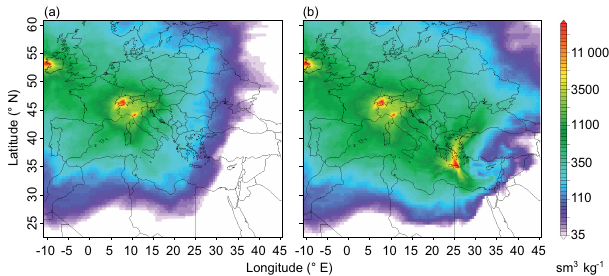
Figure 1. Average FLEXPART-derived source sensitivities for the inversions period and domain for (a) the measurements at the AGAGE stations Mace Head (MHD), Jungfraujoch (JFJ) and Monte Cimone (CMN) and (b) the additional measurements at Finokalia